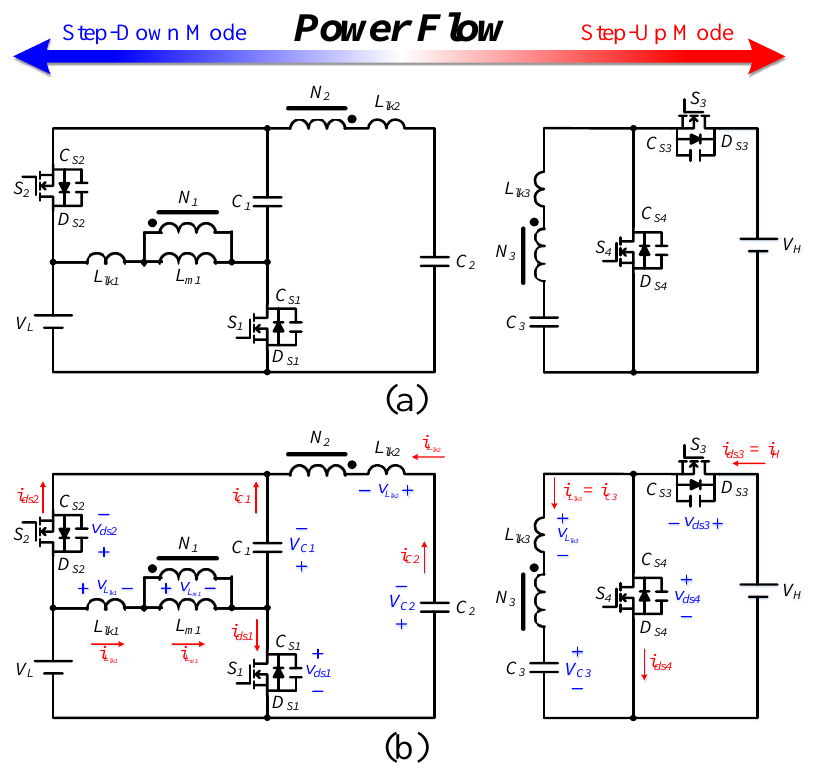
Figure 3. The proposed topology: ( a ) diagram of the bidirectional isolated DC–DC converter and ( b ) the definitions for the equivalent circuit diagram.